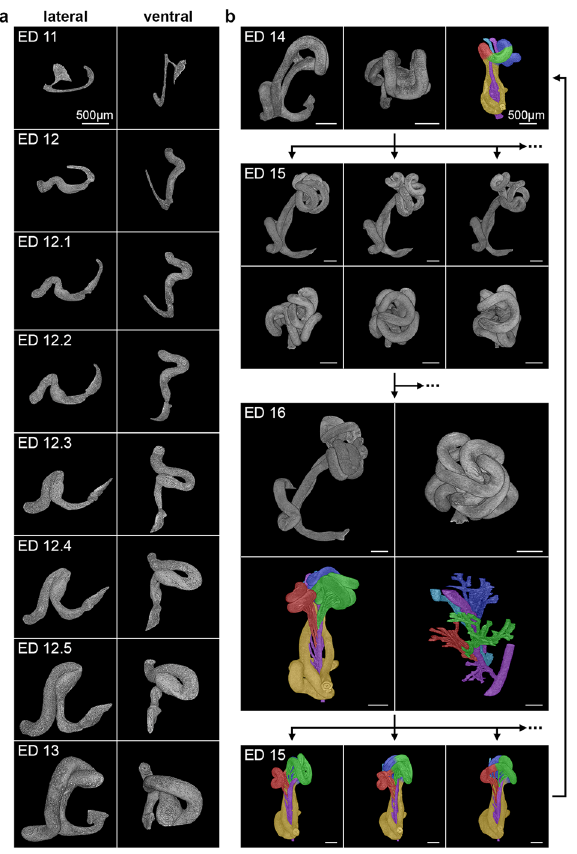
Fig. 4 Intestinal growth patterns from ED 11 to ED 16. a Scaled development of the fi rst intestinal loop. The ductus omphaloentericus disappears between ED 11 and ED 12, and the fi rst intestinal loop is formed in that area. At ED 12.1, the cecum appears and allows separation between the small and large intestines. The picture sequence from ED 12.2 to ED 13 shows the convergence of the duodenal and colonic limb, resulting in a side-by-side position of the colon and the intestine, mimicking a rotation of 90°. This growth pattern was observed in all animals in these age groups and therefore represents a conserved growth pattern. b ED 14 represents the last developmental stage with this stereotypical pattern. Further intestinal growth leads to a semi-random arrangement of additional emerging loops, as shown in ED 15. This semi-random loop growth continues. Evaluation of the supplying vessel system on ED 16 unveiled an underlying pattern, which allows the understanding of this semi-random loop arrangement. Hence, structures, such as vessels and loop clusters, are colorized (duodenum + colon: yellow, 1 st cluster: red, 2 nd cluster: green, 3 rd cluster: blue, vitelline artery: purple, vitelline vein: turquoise). This pattern in turn can be traced back to ED 15 and eventually to ED